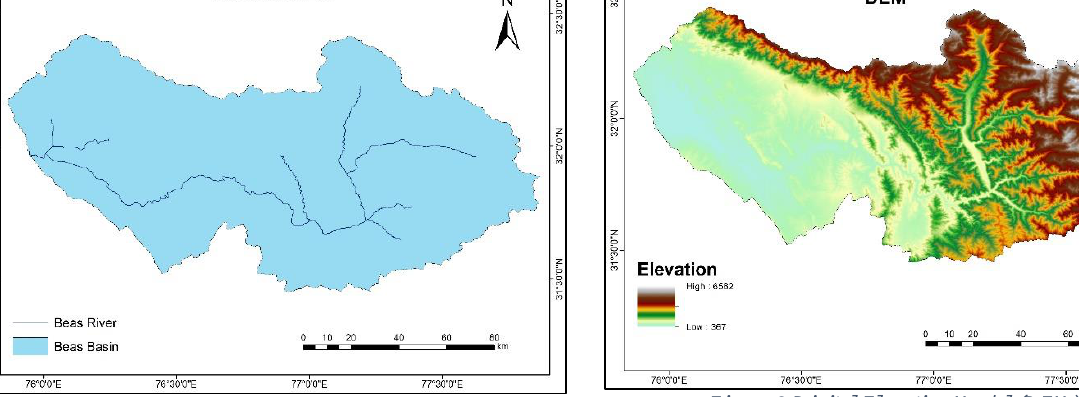
Figure 2 Digital Elevation Model (DEM)